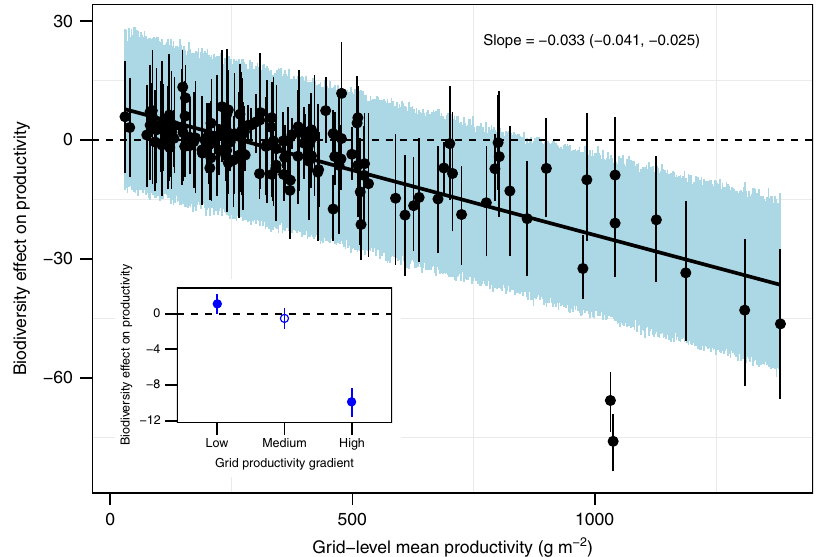
Fig. 5 Shift in the sign and strength of the biodiversity effects across productivity gradients in hierarchical Bayesian models. Each point represents the mean productivity (horizontal axis) and the median value of biodiversity effect on productivity (vertical axis) at each grid ( N = 151 grids) or grid group (low, medium, and high productivity groups in the inset). Vertical lines represent the 95% of credible intervals (CI) of estimated biodiversity effects. The solid line is the estimated relationship between mean productivity and biodiversity effect. The shaded area is the 95% CI of the estimated relationship. The text shows the median and 95% CI of the slope. The fi lled blue circles in the inset represent signi fi cant results. Source data are provided as a Source Data fi